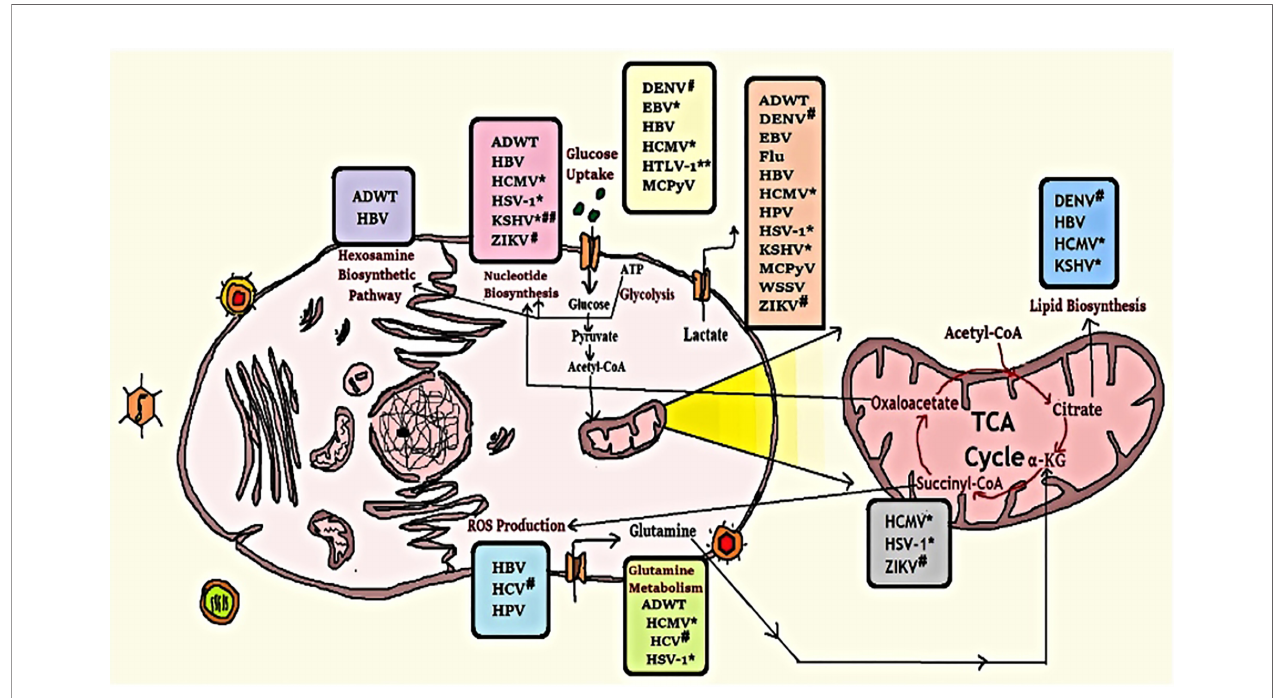
FIGURE 4 | Modi fi cation of some metabolic pathways due to viral infection. Human cell metabolism systems alter by viral infection as they rely on host cell machinery to multiply; viruses promote human anabolism for the generation of macromolecules for replication and assembly. *Herpes-virus family; #Flavivirus family; **down-regulates this metabolic activity; ##up-regulates lipid synthesis but down-regulates cholesterol synthesis